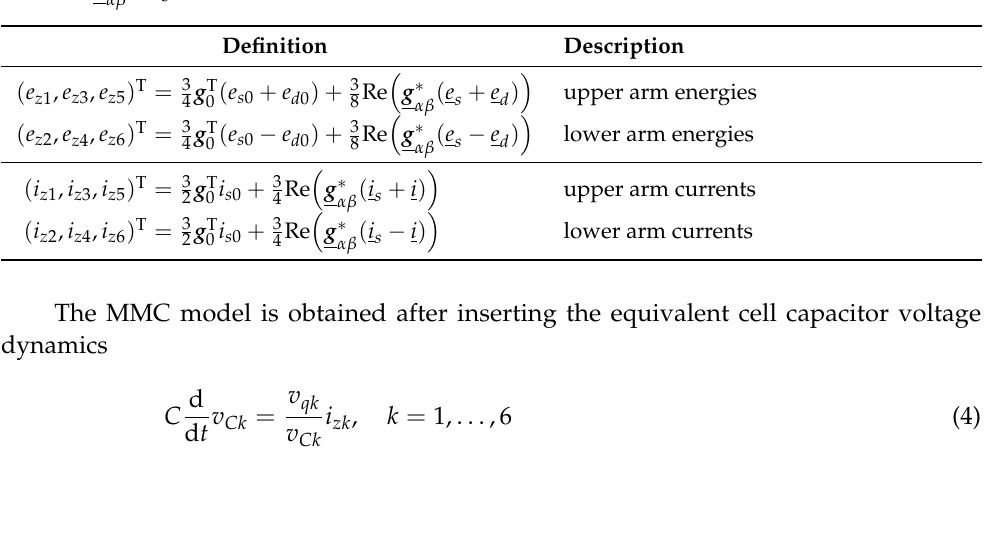
Table 2. Calculation of MMC arm energies and currents from the transformed variables in Table 1, = 1 ( 2, a ∗ , a ) T in which g ∗ 3 αβ